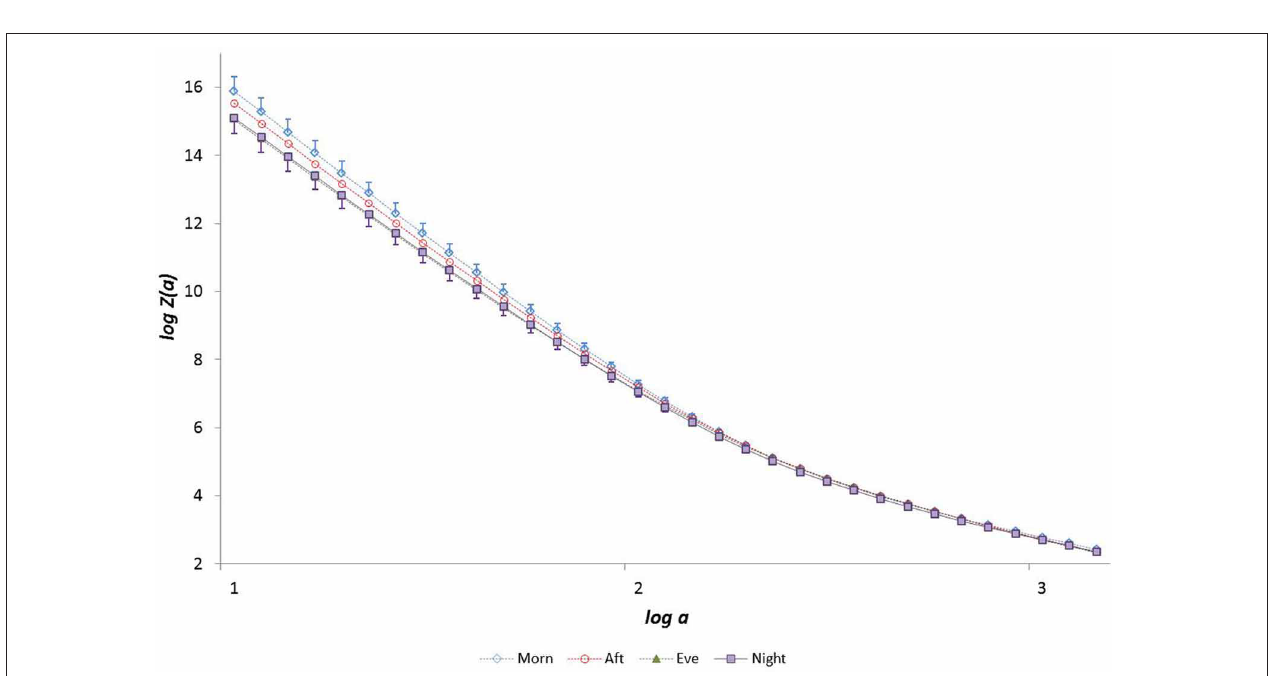
FIGURE 3 | The partition function Z ( a ) from the WTMM procedure as a function of scale a (for moment q = − 5).